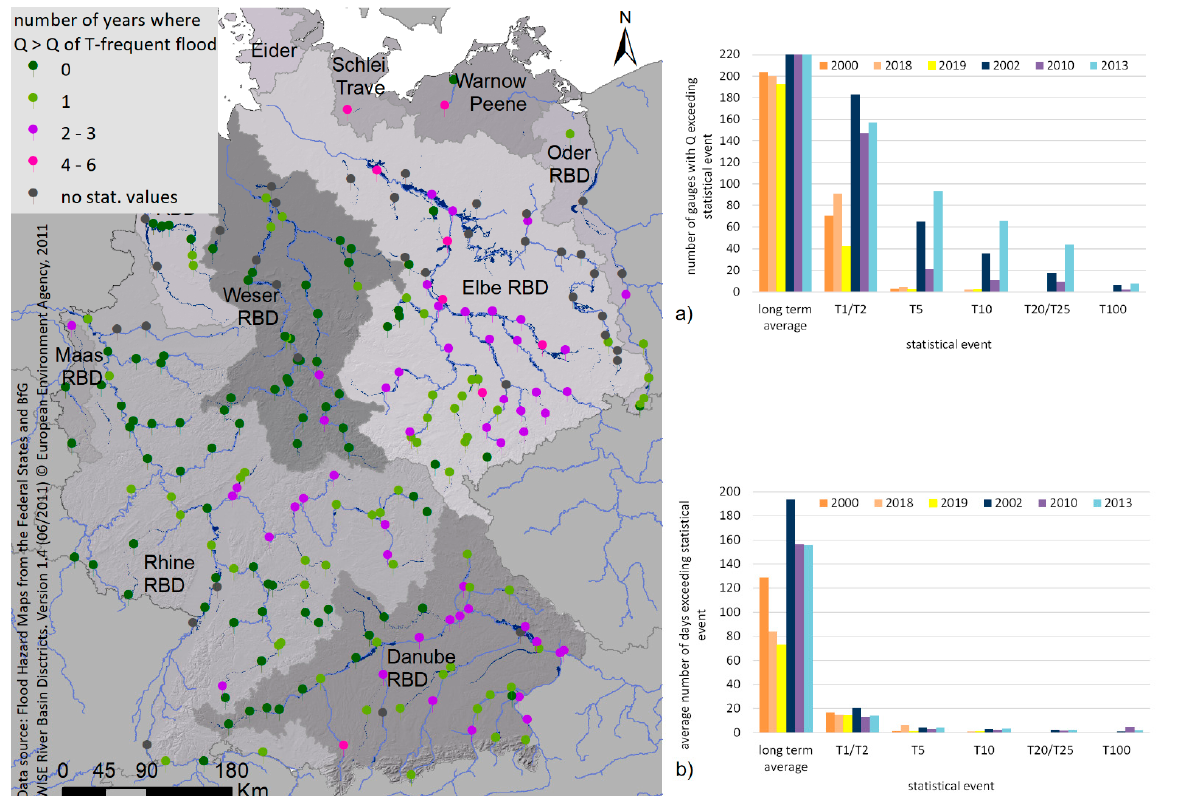
Figure 7. Gauges showing the numbers of years with discharges (Q) exceeding the statistical events of Q of T–frequent floods. ( a ) Comparison of discharges exceeding selected thresholds including long–term average (average) at gauges all over Germany in dry (orange to yellow) and wet years (blue and purple) between 2000 and 2019. ( b ) Average number of days with discharges exceeding selected thresholds for all gauges with exceedance.